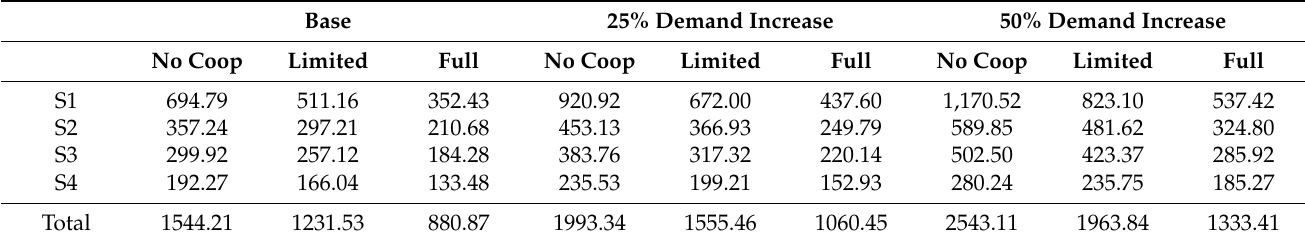
Table 5. Average distance driven (km) in the 100 replications for non-, limited, and full cooperation settings for each supermarket by demand increase scenario.